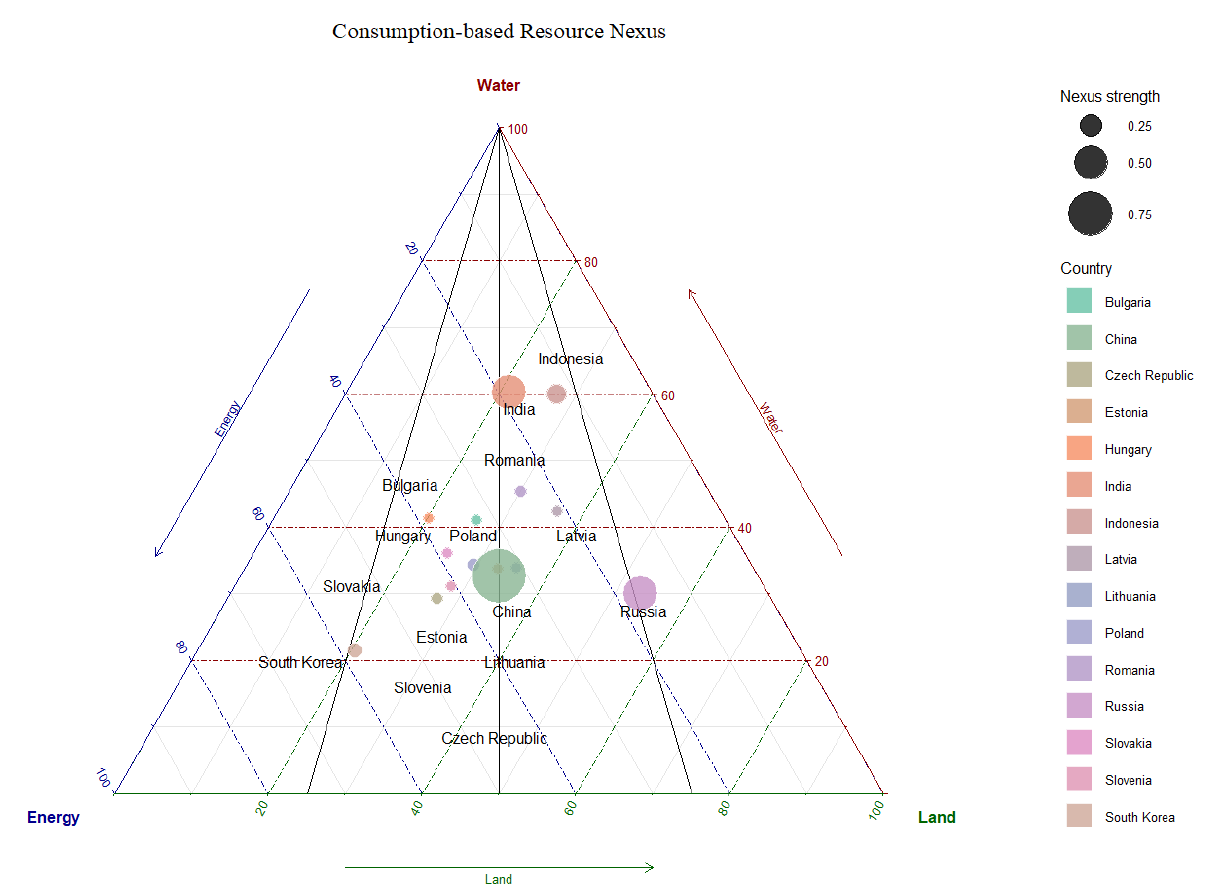
Figure 7. Nexus strength results by country based on the consumption viewpoint. Lines that cut the point position represent aggregated usage of a given resource. Size of the point/or circle inside the triangle shows the combined contribution of the three resources. Location of a point within the triangle provides a series of key information that can be used to compare its resource use combination with other countries.